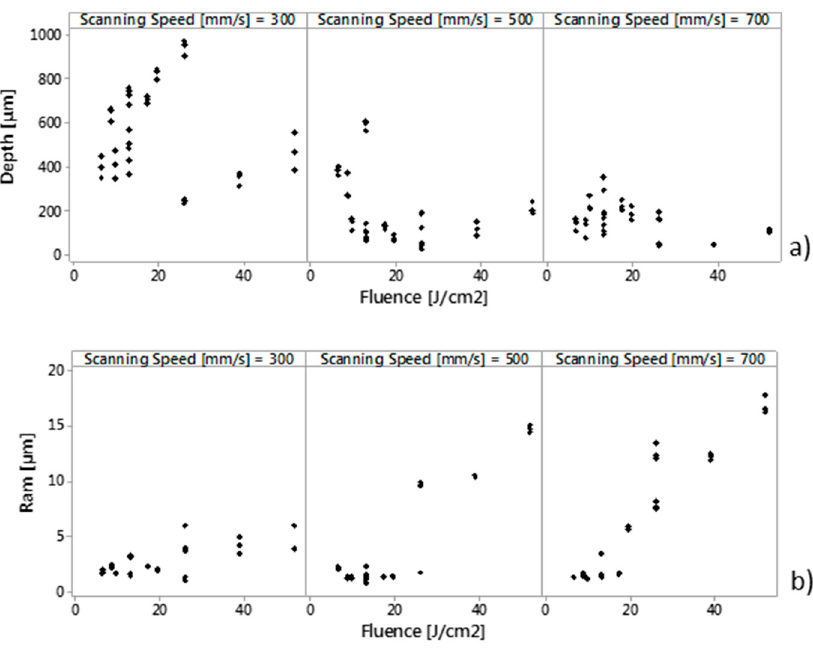
Figure 12. Scatterplot of Depth ( µ m) ( a ) and Ram ( b ) vs. Fluence (J/cm 2 ) with panel variable scanning speed.